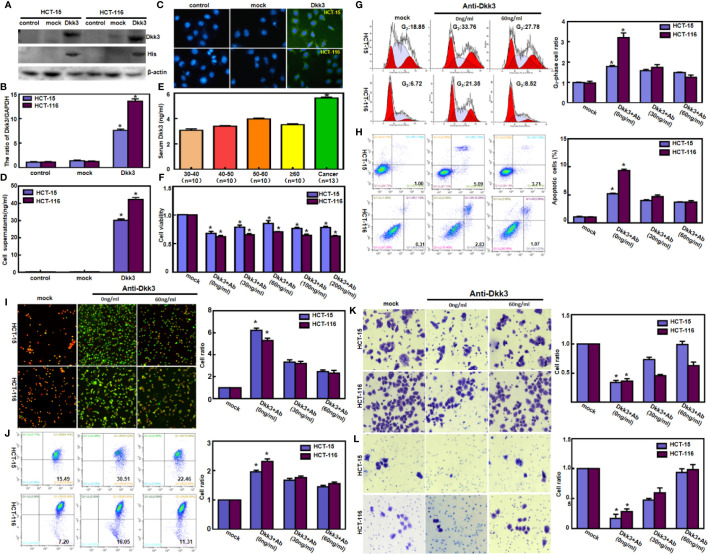
Dkk3 overexpression suppressed the aggressive phenotypes of colorectal cancer cells. After transfection of pcDNA3.1-Dkk3, Dkk3 expression became strong in HCT-15 and HCT-116 cells using anti-Dkk3 and anti-His antibodies by Western blot (A), real-time RT-PCR (B), and immunofluorescence (C, green: positive for Dkk3, blue: DAPI for nuclei). The cell culture supernatant of Dkk3 transfectants showed a higher Dkk3 concentration in comparison with those of the control and mock (D). Colorectal cancer patients showed a higher serum Dkk3 level than healthy individuals regardless of their age, evidenced by ELISA assay (E). The transfectants showed a lower proliferation (F) and G2 arrest (G) in comparison with the control and mock. There was an apoptosis-induced effect of Dkk3 overexpression in the transfectants of HCT-15 and HCT-116, evidenced by annexin V assay (H). JC-1 staining displayed that the mitochondrial membrane potential was decreased in the abovementioned cells with Dkk3 overexpression by fluorescence (I) and flow cytometry (J). Dkk3-overexpressing cells had a weaker ability to migrate (K) and invade (L). We also treated the Dkk3 transfectants with anti-Dkk3 antibody (0, 30, and 60 ng/ml) and found that this antibody blocked the effects of Dkk3 overexpression on these phenotypes (F–L, p < 0.05). mock, cells transfected with pcDNA3.1 vector; *P < 0.05, compared with the control and treatment with anti-Dkk3 antibody.